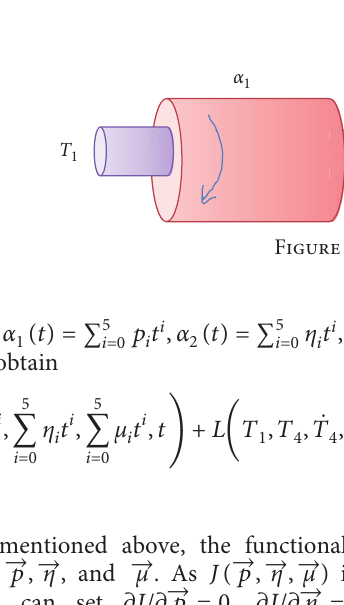
Figure 6: The error of the generator system solution for θ � t 4 + t 2 .